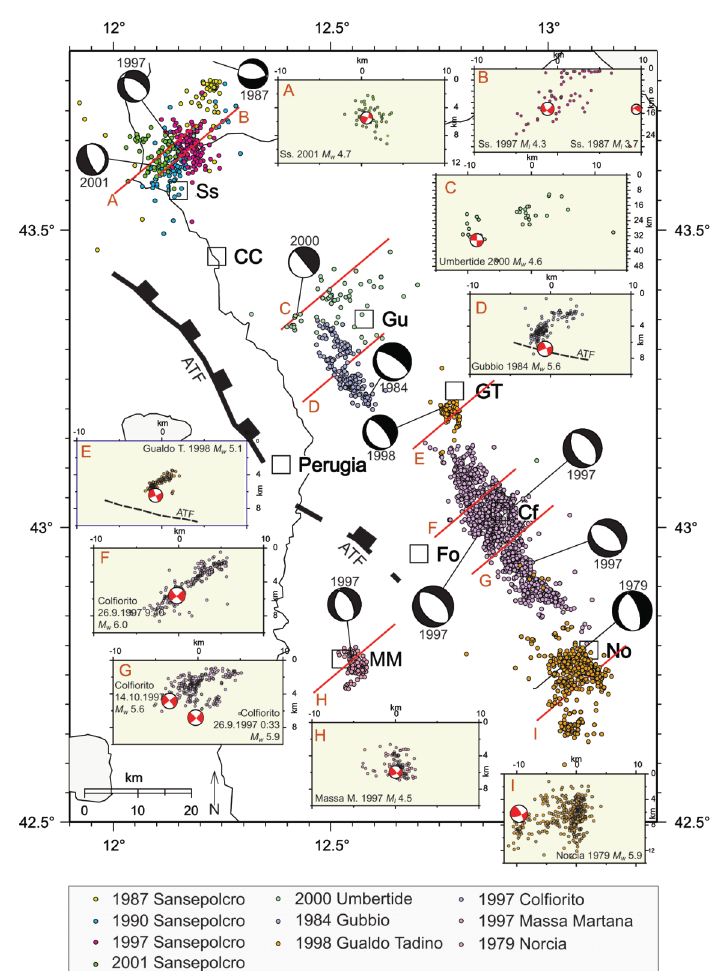
Fig. 6. Epicenters of the main seismic sequences that have occurred in the study area, including hypocenter sec- tions and focal mechanisms of the mainshocks as described in the text (Di Luccio et al. , 1998; Chiaraluce et al. , 2003; Collettini et al. , 2003; Castello et al. , 2005; Ciaccio et al. , 2005). Note that the vertical scales on the seis- mic sections vary for different hypocentral